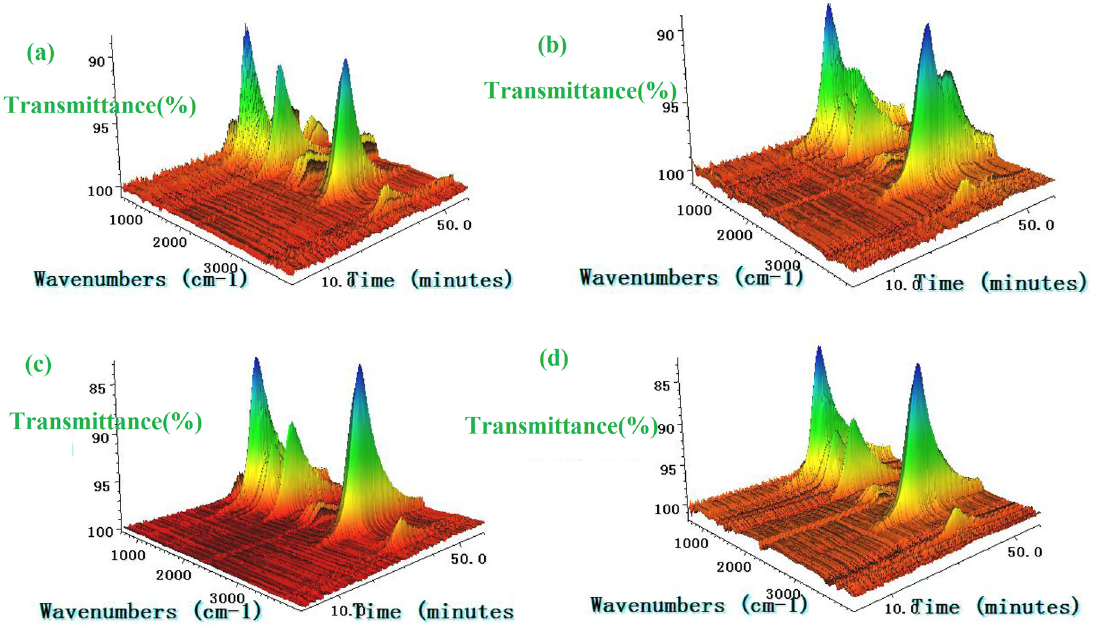
Figure 19. Three − dimensional FT − IR of EC ( a ), EC − 1 − 1.0 − 2SH ( b ), EC − 1 − 1.0 − 4SH ( c ) and EC − 1 − 1.3 − 4SH ( d